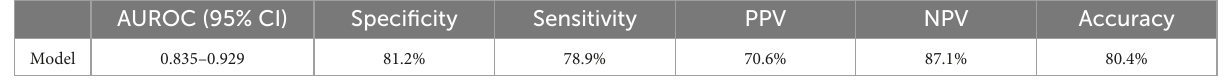
TABLE 3 The characteristics of the predictive